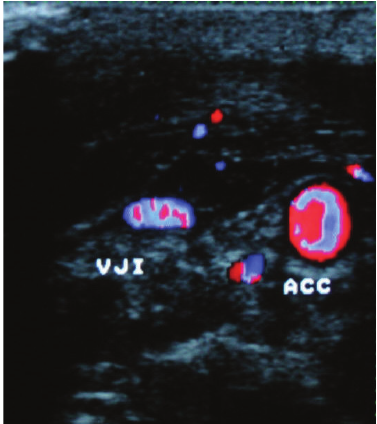
Figure 2: Postoperative duplex scan of case #1 showing patent left external jugular vein (EJV), collateral veins (C), and common carotid artery